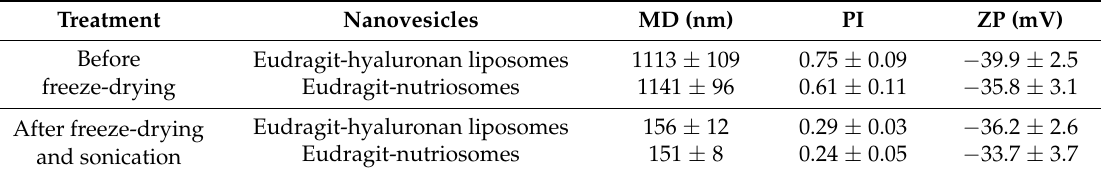
Table 2. Mean diameter (MD), polydispersity index (PI) and zeta potential (ZP) of curcumin-loaded Eudragit-hyaluronan liposomes and Eudragit-nutriosomes. Each value represents the mean ± standard deviation, n ≥